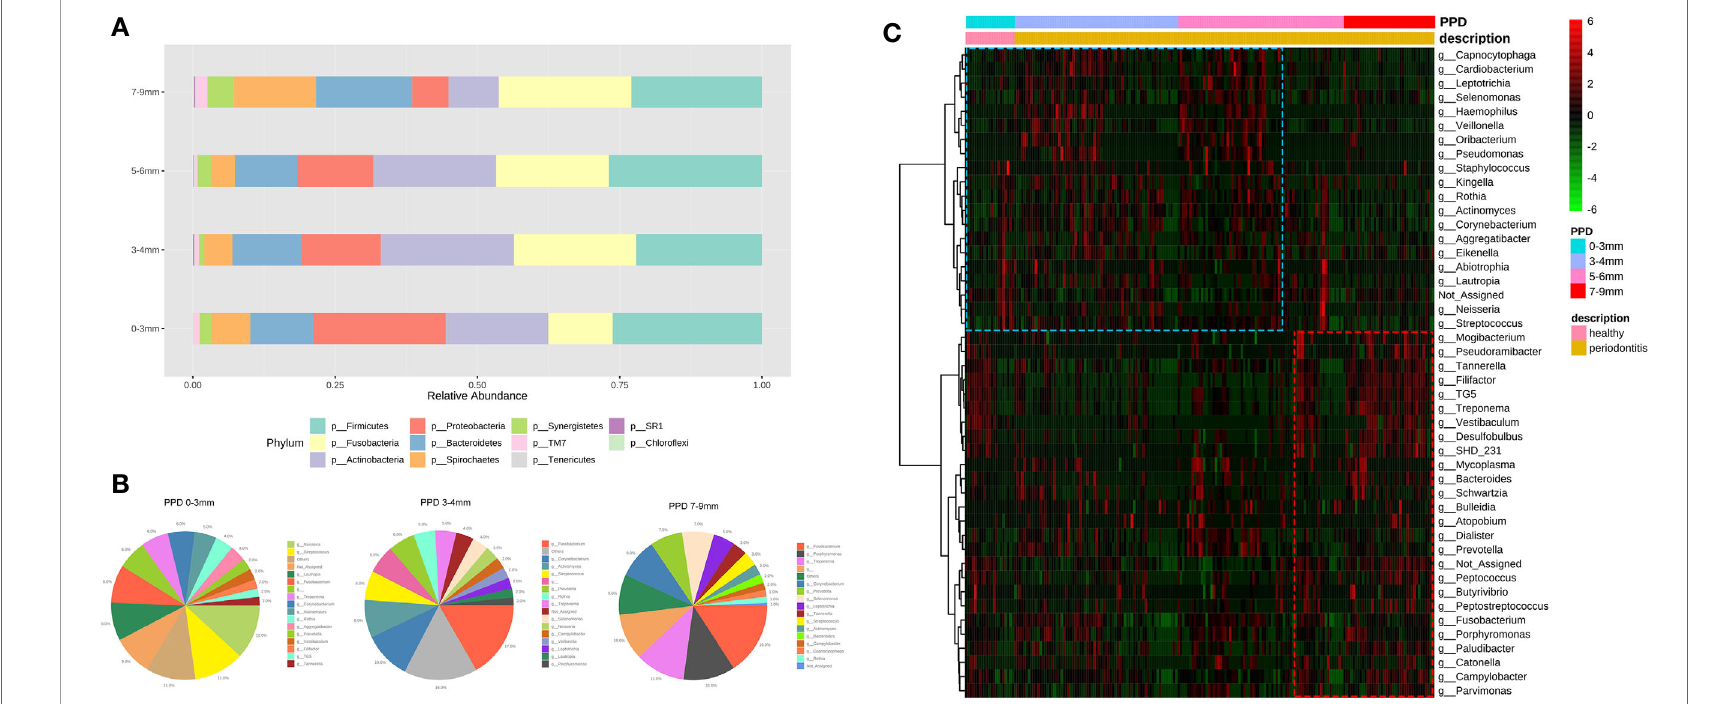
FIGURE 4 | (A) The taxonomic bar plots on the genus level. Each bar represents a group of different periodontal probing depth (0 – 3 mm, 3 – 4 mm, 5 – 6 mm, and 7 – 9 mm). (B) Three pie charts display the genera (abundance >1%) in the sites of PPD 0 – 3 mm, 3 – 4 mm, and 7 – 9 mm. The taxonomy “ others ” is a cluster of genera whose abundance are less than 1%. (C) The heatmap shows the correlations between taxa and PPD. Each column represents a sample, each row represents a taxon, and each lattice represents a correlation coef fi cient between a taxon and PPD group (red lattice, positive correlation; green lattice, negative correlation). With the deepening of pocket depth, the pathobionts increase (red box) and some normal microbes decrease (blue